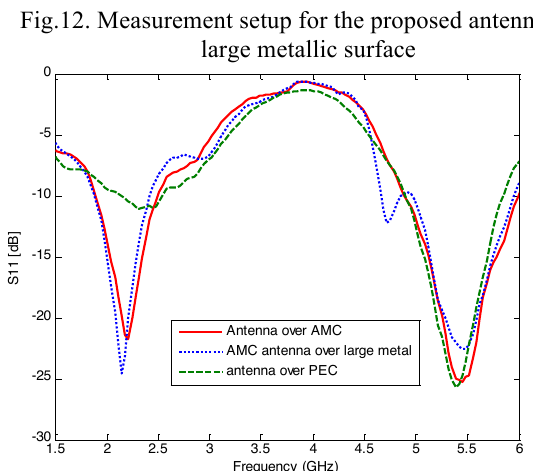
Fig .13. Measured return loss for various cases The simulated and measured gain performances of antenna alone and antenna with AMC for two operating bandwidth are illustrated Table. 3.The cpw antenna gain is about 2.72 and 3.45 dB for 2.44GHz and 5.27GHz .With AMC reflector, the measured antenna gain is improved by factor of 5.17 and 5.75 dB for lower and higher operating frequencies . It can be noticed that the gain and directivity increase by using AMC reflector